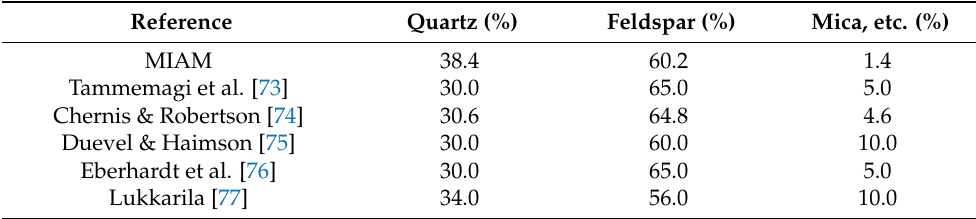
Table 3. Mineralogical composition of the Lac du Bonnet